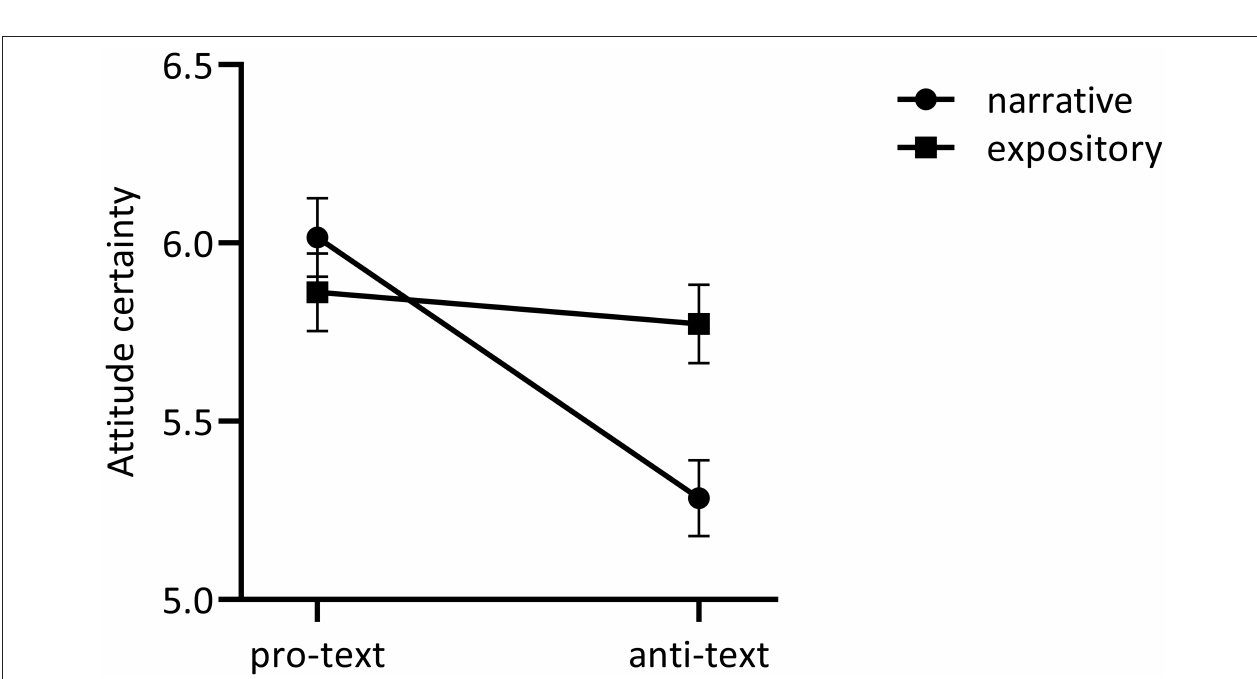
show significant interactions for those with moderately